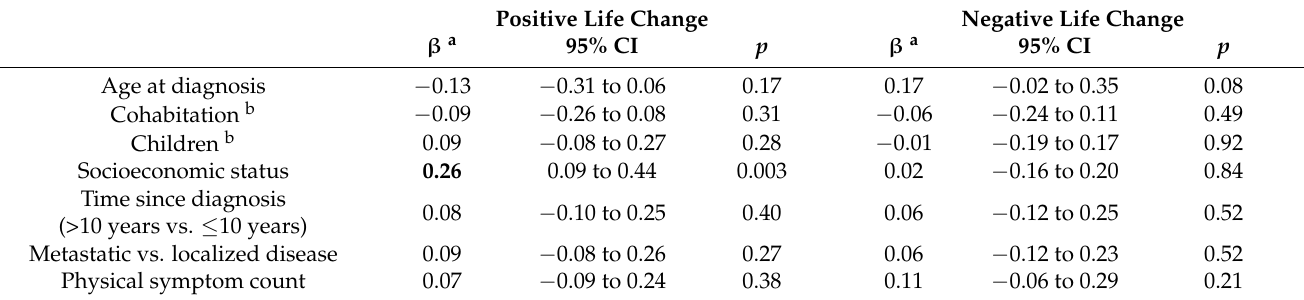
Metastatic vs. localized disease